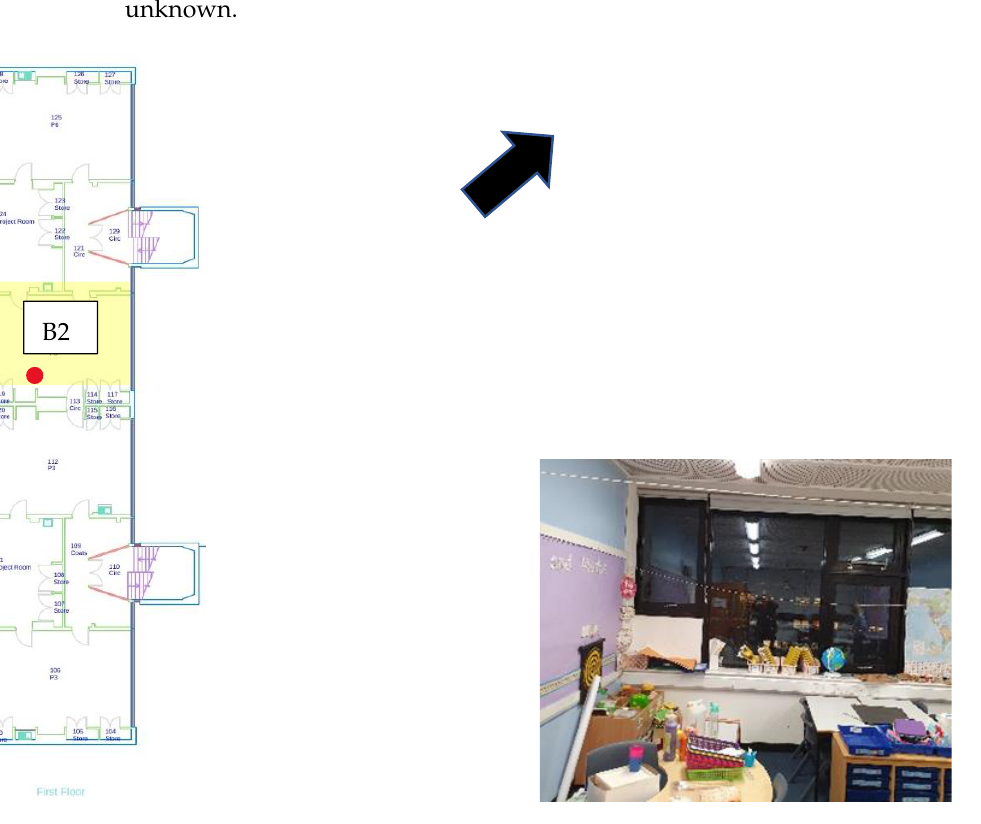
Figure 26. Classroom B2 on first floor of school B.